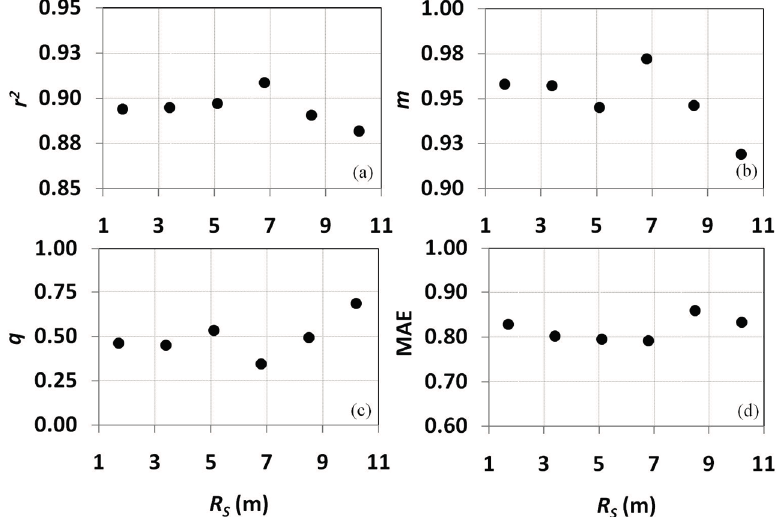
Figure 7. Variability of some statistical parameters used to characterize in situ vs. remote sensing θ at increasing θ Rs aggregation scale: ( a ) r 2 , upper left; ( b ) m , upper right panel; ( c ) intercept q , lower left panel; ( d ) MAE, lower right